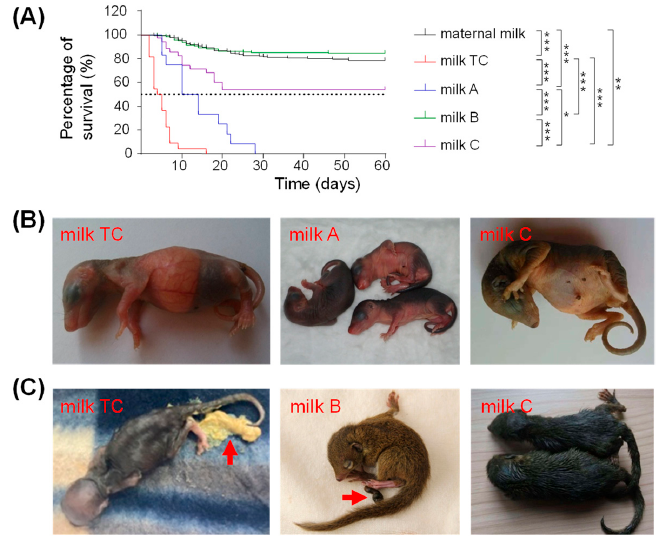
Figure 5. Survival curves and morphology of pups fed with maternal milk and artificial milk. ( A ) Kaplan–Meier survival curves of pups fed with different milks. Maternal milk, n = 224; milk TC, n = 22; milk A, n = 12; milk B, n = 214; and milk C, n = 35. * p < 0.05, ** p < 0.01, and *** p < 0.001. ( B , C ) Representative pictures of pups fed with different milk substitutes. ( B ) On postnatal day 4, pup fed with milk TC was skinny and has gastric food retention; pups fed with milk A had a completely empty stomach before feeding every morning; pups fed with milk C had mild diarrhea. ( C ) Pup fed with milk TC on postnatal day 13 had diarrhea with liquid, yellow stool (indicated by an arrow) and dehydration. Pup fed with milk B on postnatal day 22 had brown, soft, sausage-shaped feces (see arrow). Pups fed with milk C on postnatal day 18 had severe diarrhea. Autopsy of the dead pups showed that digestive disease was the leading cause of the death before the weaning age for all pups (Table 3). Nonetheless, the pups fed with milk TC seemed to be more vulnerable to digestive disease (90.9%, 20/22) than the dead pups in the MR group and three sub-groups of the AR group (47.6%, 50/105). The pups fed with milk TC frequently had severe gastric food retention (Figure 5B). A total of 20 out of 22 pups fed with milk TC had watery diarrhea with yellow stool (Figure 5C), and eventually died of dehydration within a few days. The pups fed with other types of milk had no such severe gastrointestinal problems (Figure 5B) and their excrement was usu- ally in strip form with a brown color (Figure 5C). Although a few pups fed with milk A,